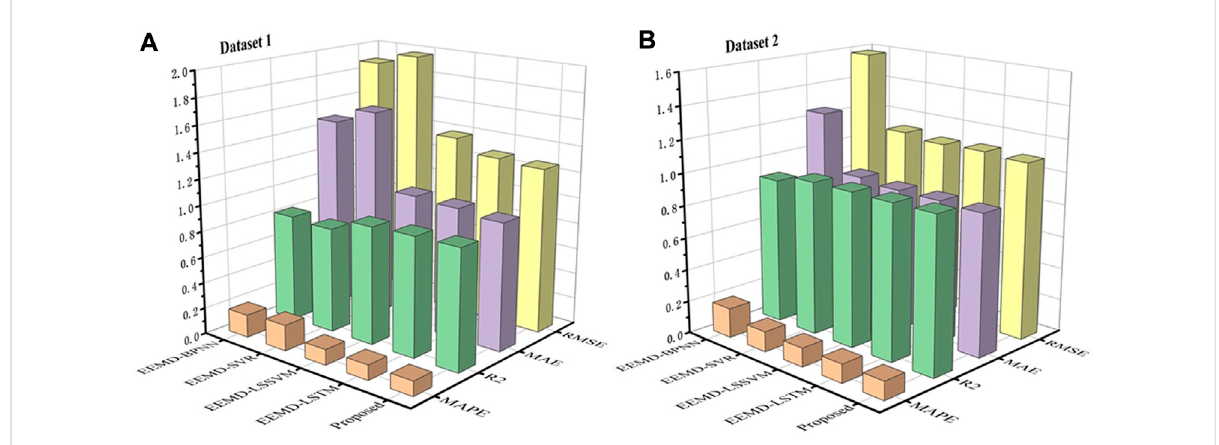
FIGURE 7 Result comparison of fi ve models on experiment Ⅱ (A) Dataset 1. (B) Dataset